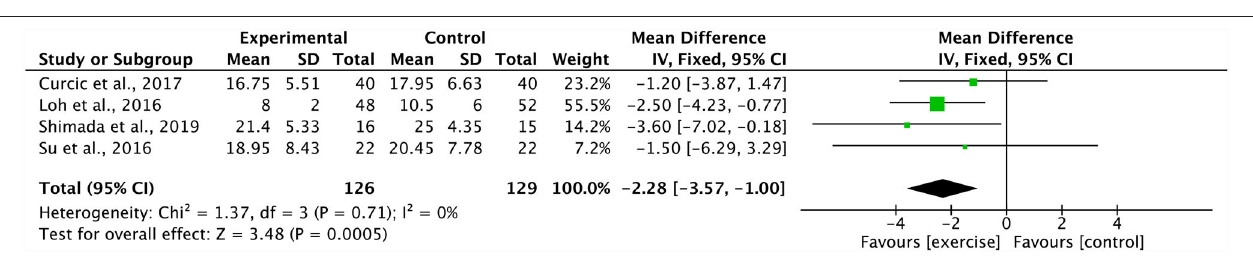
FIGURE 3 | The effects of aerobic training on PANSS negative scores.